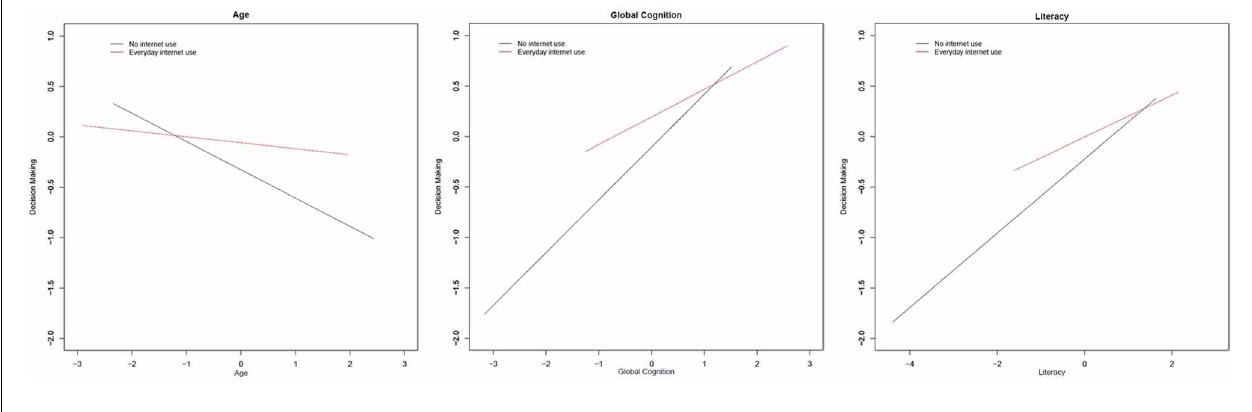
FIGURE 1 | Significant interactions of frequency of internet use with covariates on decision making ability. All models included terms for age, sex, race, education, and global cognition. Based on standardized beta coefficients. Red line